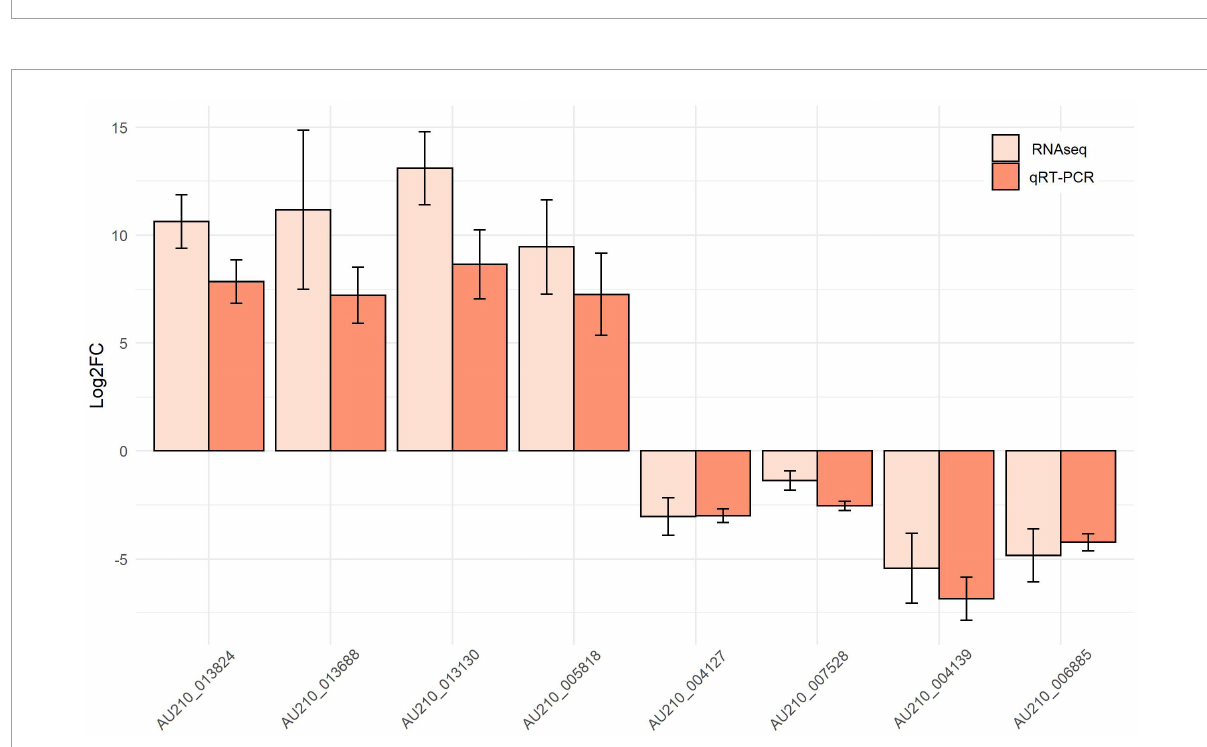
FIGURE7 Co-expression network analysis of the blue module. The red to yellow circles represent the hub genes identified by cytoHubba in Cytoscape, and the color shade indicates the correlation.